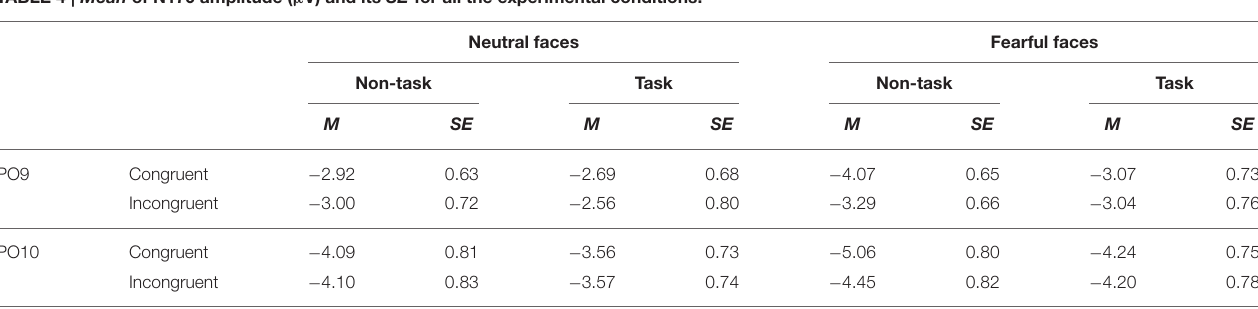
FIGURE 5 | Topographical maps based on mean amplitudes of N170 (130–180ms) and P3 (450–650ms) for all experimental conditions.